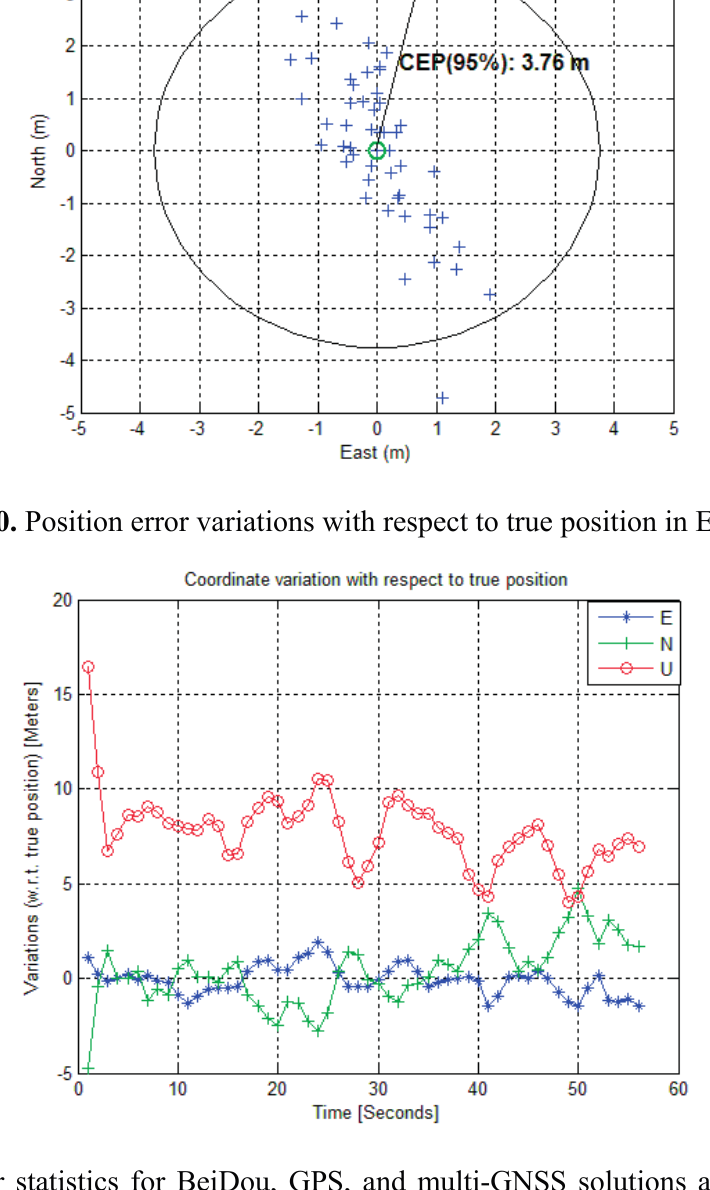
Table 3. The error statistics were computed for a stand-alone code-phase based position solution. The broadcasted Klobuchar ionospheric model parameters are utilized to calculate the ionospheric corrections. The position error statistics were computed with respect to the true known position. The 3D RMS errors for BeiDou and GPS are 8.24 m and 2.80 m, respectively. The error contribution for